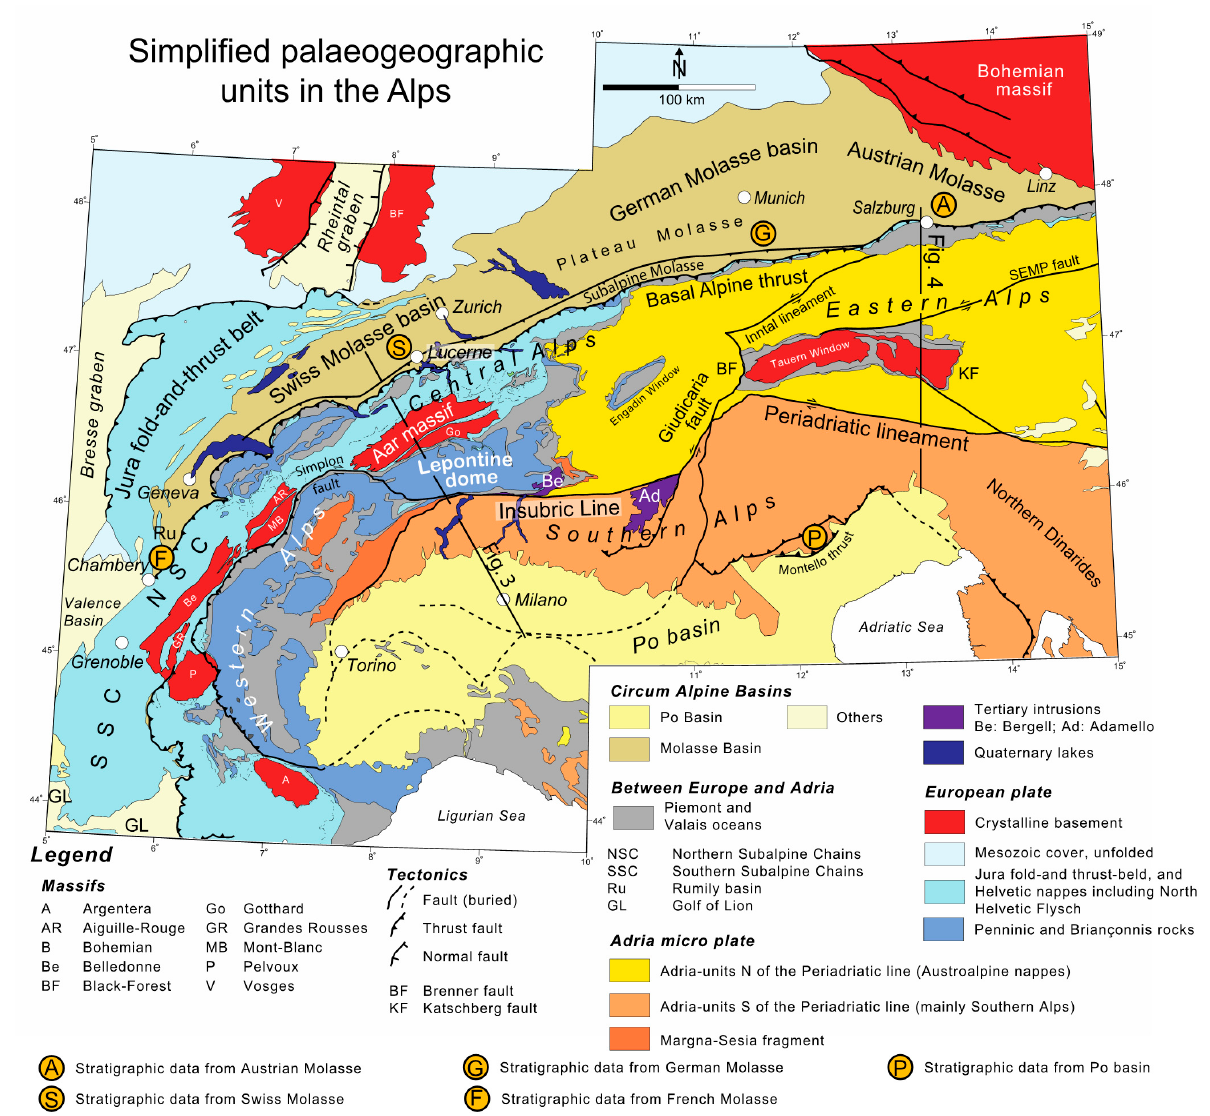
Figure 2. Geological map of the Western, Central, Eastern and Southern European Alps [30–33]. Rocks of European origin occur in the Jura fold-and-thrust belt, in the Northern (NSC) and Southern Subalpine Chains (SSC), and along the thrust front of the Central and Eastern Alps (Helvetic nappes). Slivers of the Iberian plate (e.g., Briançonnais rocks and crystalline basement rocks in the hangingwall of the Simplon fault) were part of the European plate since c. 35 Ma. The Lepontine dome is a structure that was exhumed through slip along the Simplon fault. It exposes high-grade basement rocks of European origin. The lithologies of the Adriatic continental plate constitute the Southern and Eastern Alps and cover a large area. During the Mesozoic phase of spreading, the continental plates were separated by the Valais and Piemont Oceans. The related (meta)sedimentary rocks were thrust on top of units of European origin during the Alpine orogeny. A major tectonic fault, referred to as the Periadriatic lineament (or Insubric Line west of the Giudicaria fault), separates the northern from the southern portions of the Alps with north- and south-vergent thrusts, respectively. Backthrusting along this fault facilitated the rise of the Tertiary magmas. This fault was offset by left-lateral faulting along the Giudicaria fault. The Alps are bordered by the Molasse foreland basin in the North and the Po basin in the South: A (Austrian Molasse), G (German Molasse), S (Swiss Molasse), F (French Molasse) and P (Po basin) are the sites for which stratigraphic data was used to reconstruct the subsidence history of the foreland plate.